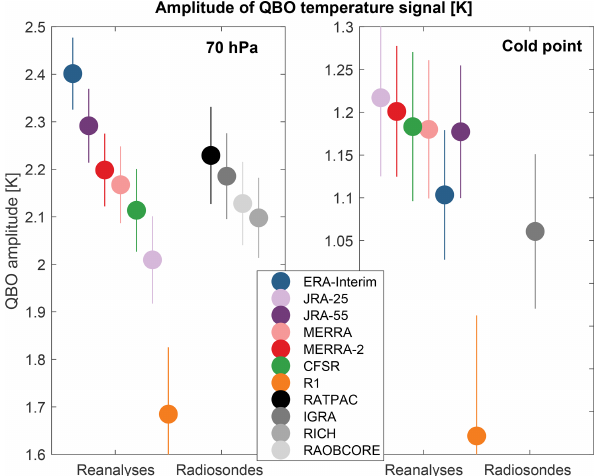
Figure 10. Amplitude of QBO temperature signal for 10 ◦ S–10 ◦ N at 70hPa and the cold point derived from a multilinear regres- sion analyses for radiosonde and reanalysis data sets for the period